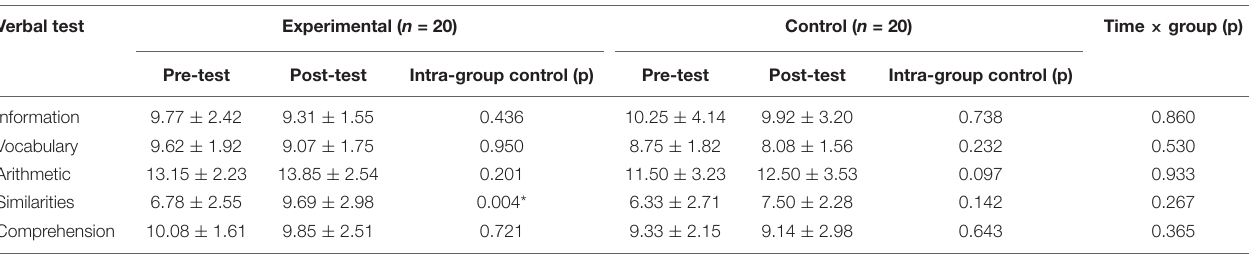
TABLE 2 | Scores of verbal test items of Wechsler Intelligence Scale in experimental class and control class before and after the experiment.